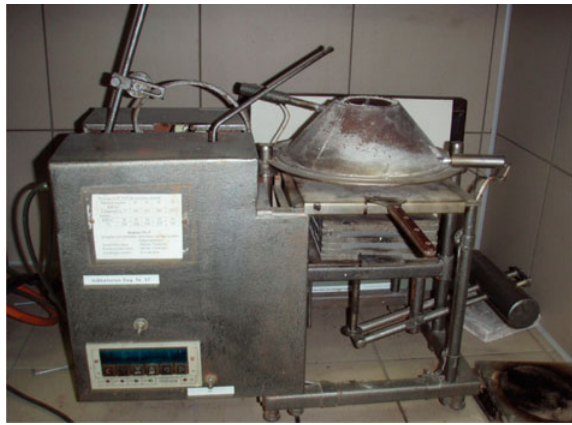
Fig. 1. LST ISO 565:1999 standard burning furnace